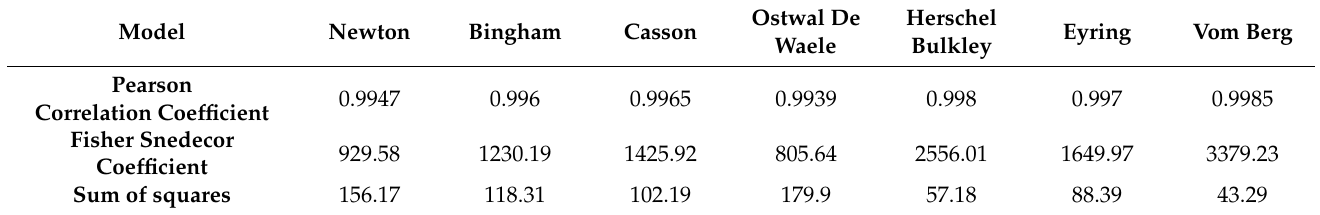
Table 3. Results of calculations with regard to rheological parameters of the tested cement slurry.